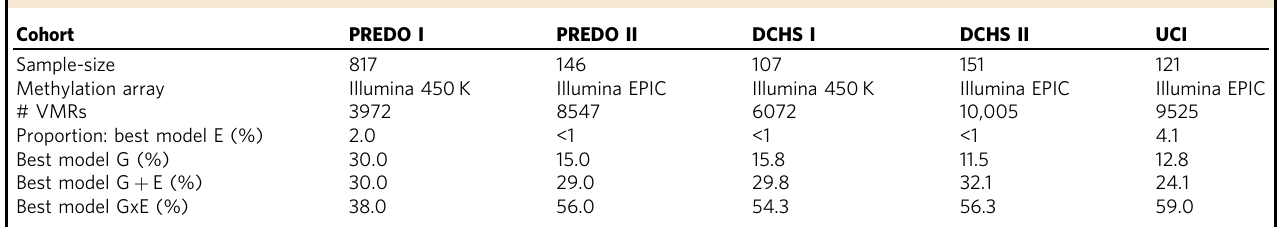
Table 2 VMRs and best models across cohorts Cohort PREDO I PREDO II